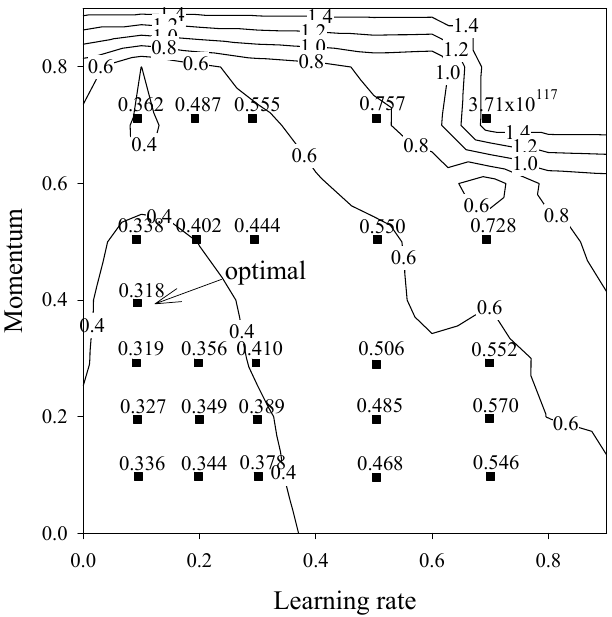
Figure 4. Contour plot of RMS as function of learning rate and momentum for the cross- validated testing